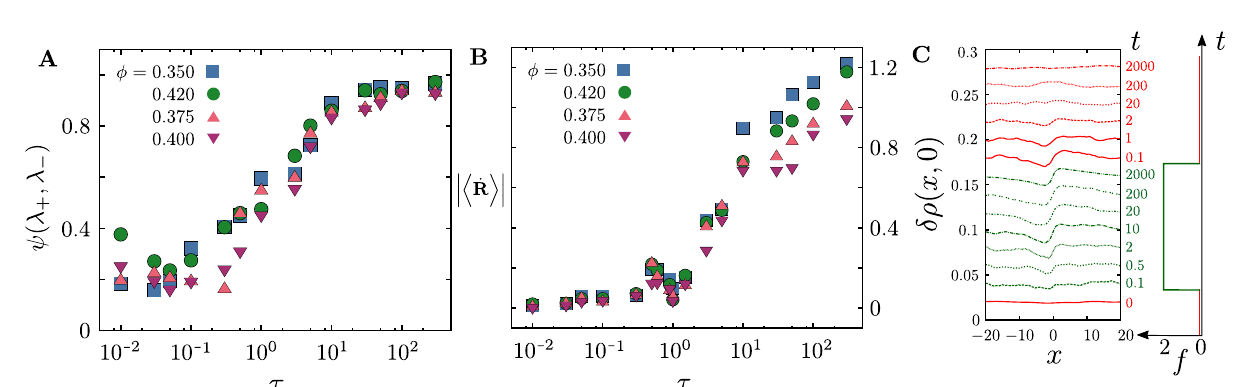
Fig.4 |Dynamicaltransitionintheactiveparticletransport.A Thegeometryof theunder-denseregionsischaracterisedbyashapeparameter, ψ = λ + (cid:3) λ (cid:3) λ aretheeigenvaluesofthemomentofgyrationtensor(SupplementaryNote3),and goes from being circular ( ψ ≈ 0) to elongated ( ψ ≈ 1) as τ increases. B Mean of the magnitude of the velocity (over a time interval Δ t =20) of the active particle, as a functionofthepersistencetime τ showsadynamicaltransitionat τ ≈ 1,belowwhich